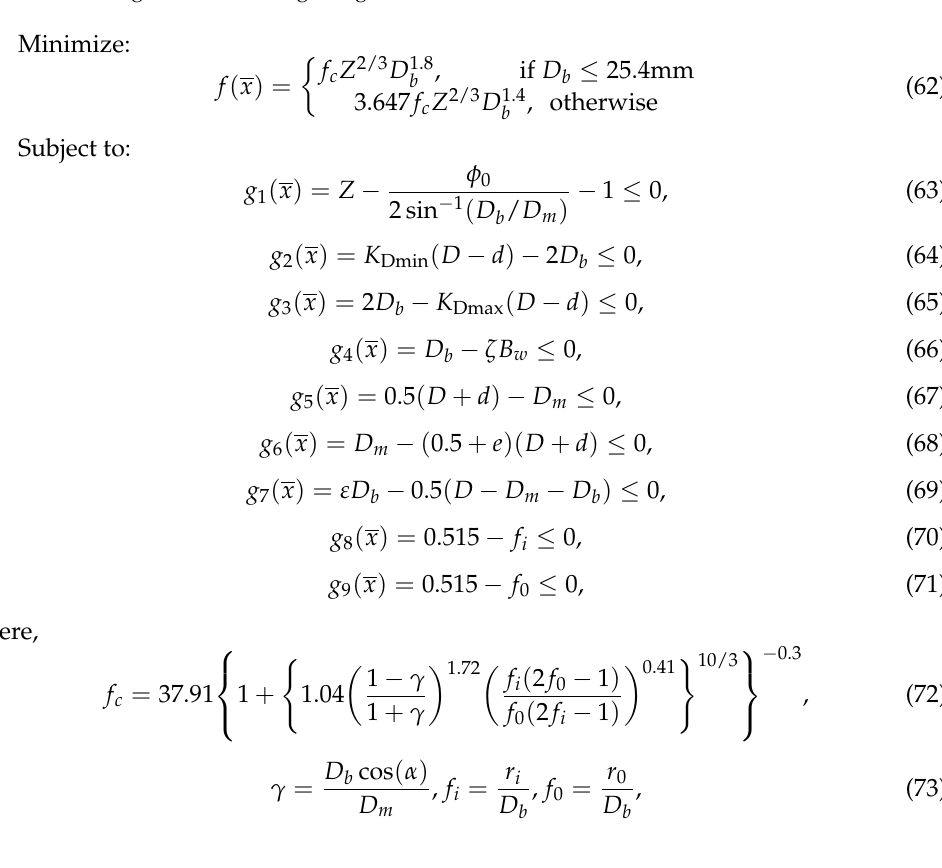
Figure 15. Rolling element bearing